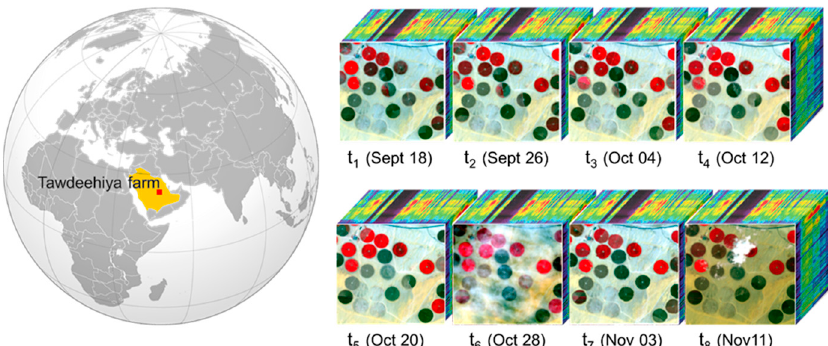
Figure 1. Location of the region of interest covered by each Hyperion swath at eight di ff erent times. Color composition for all images is described by an infrared false color, with R: Band 45 (862.01 nm) G: Band 23 (650.66 nm) B: Band 13 (548.92 nm). Crop circles correspond to alfalfa, corn, and grass fields (approximately 800 m in diameter) at di ff erent growth